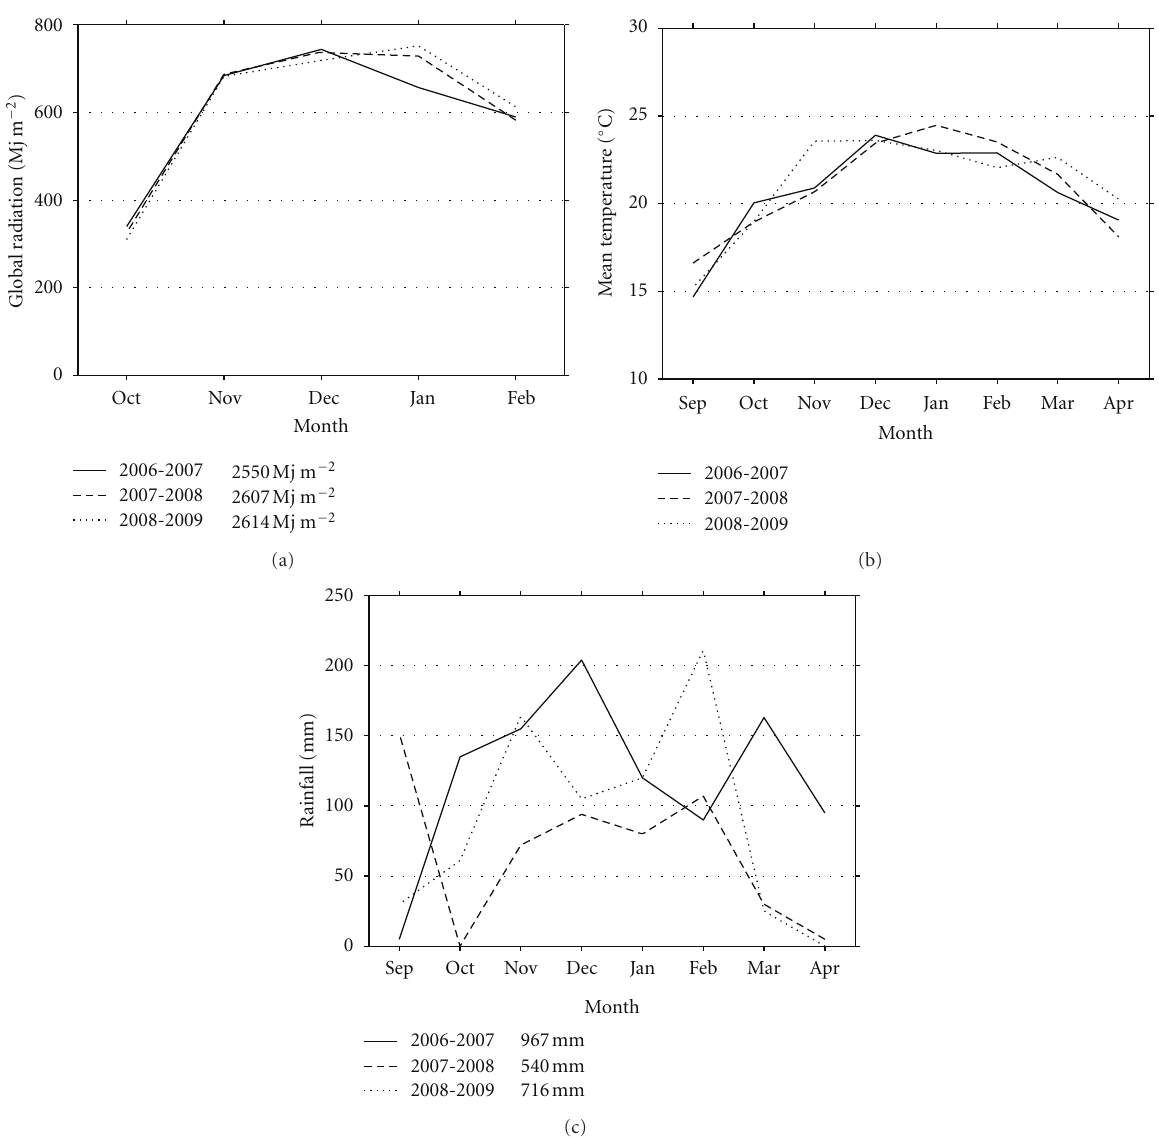
Figure 1: Weather conditions: PAR (a), mean air temperature (b), and rainfall (c) during crop cycles in C1, C2, and